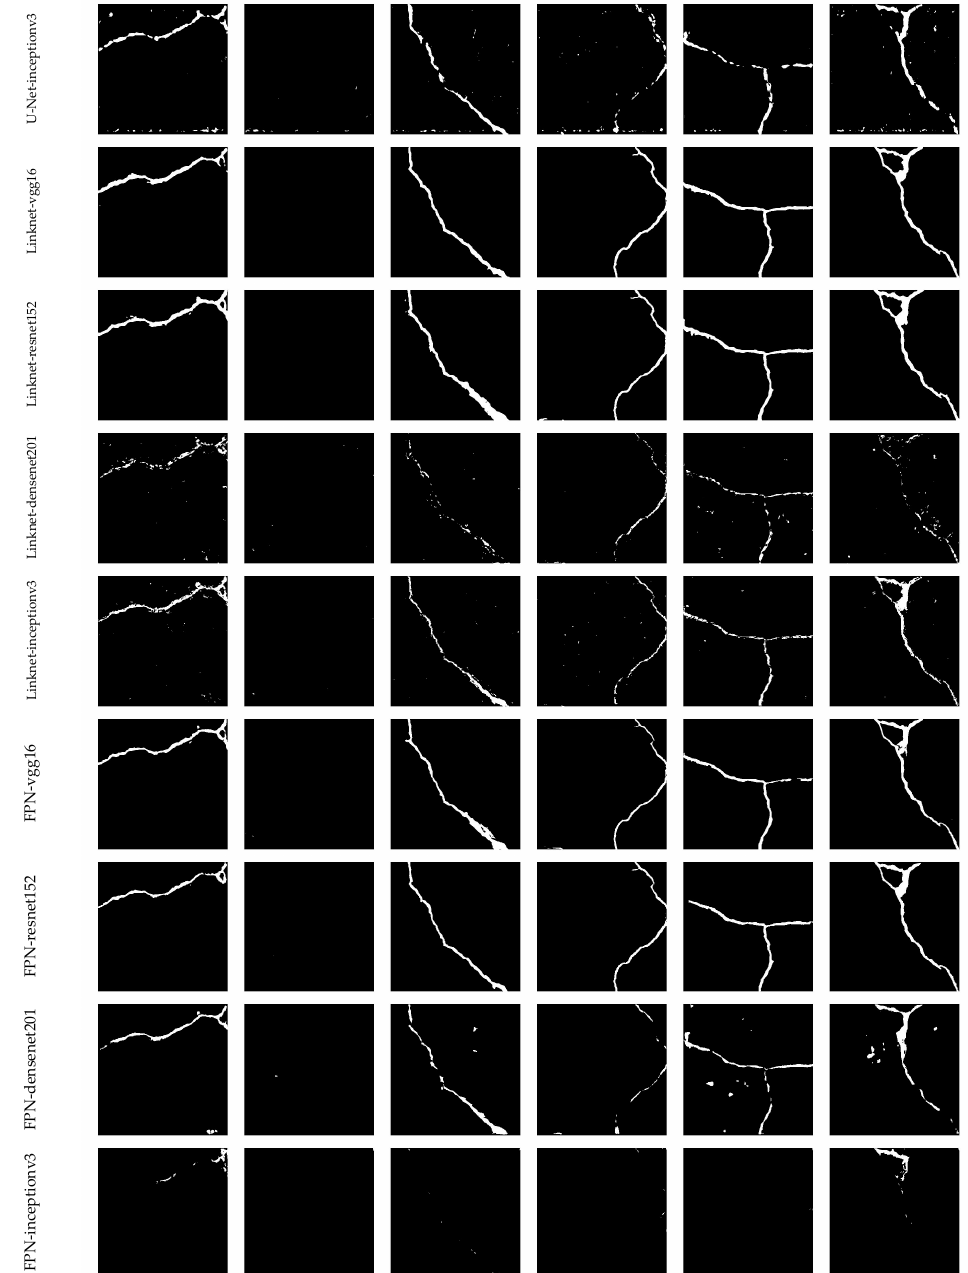
Figure 7. The original image, ground truth, and predictions with all models for different images from the validation dataset.